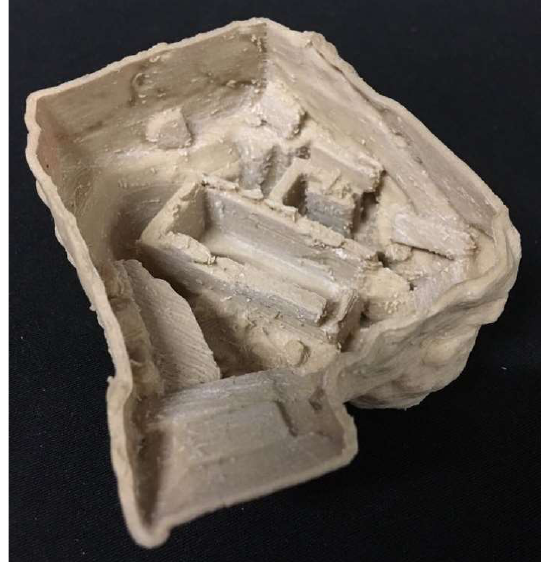
Figure 14. Sarcophagous chamber. 3D model. Scanner Faro focus 3D and SCENE software.